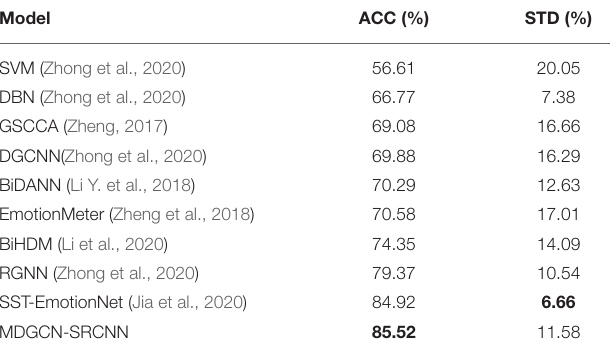
TABLE 3 | The accuracy of the proposed method is compared with the existing methods on the SEED-IV dataset. Model